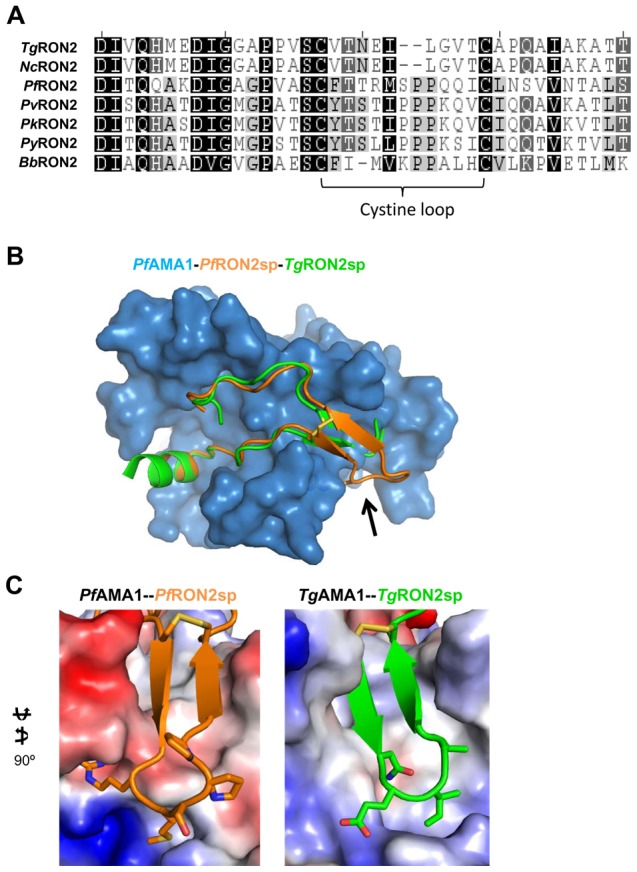
The RON2 cystine loop governs specificity.(A). Alignment of RON2 sequences truncated to correlate PfRON2sp1 with RON2 sequences from the following accession numbers: TgRON2 - TGME49_100100, NcRON2 - NCLIV_064620, PfRON2 - PF14_0495, PvRON2 - PVX_117880, PyRON2 – PY_06813, BbRON2 (BBOV_I001630). (B). Overlay of TgRON2sp (green; PDB ID 2Y8T) onto PfAMA1-PfRON2sp (blue-orange) shows that both peptides adopt a helix/coil/cystine loop/coil architecture in the AMA1 groove, with the highest divergence localized to the cystine loop (black arrow). (C). Electrostatic surface renderings of PfAMA1 (left) and TgAMA1 (right), with the secondary structure of the RON2 binding partner and residues defining the base of cystine loop shown, illustrates that both interactions are highly complementary, but highly genus specific.